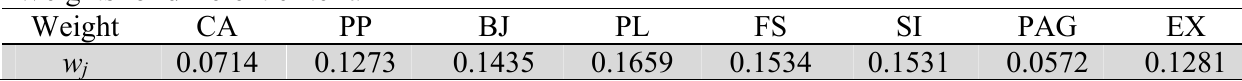
Weights for different criteria